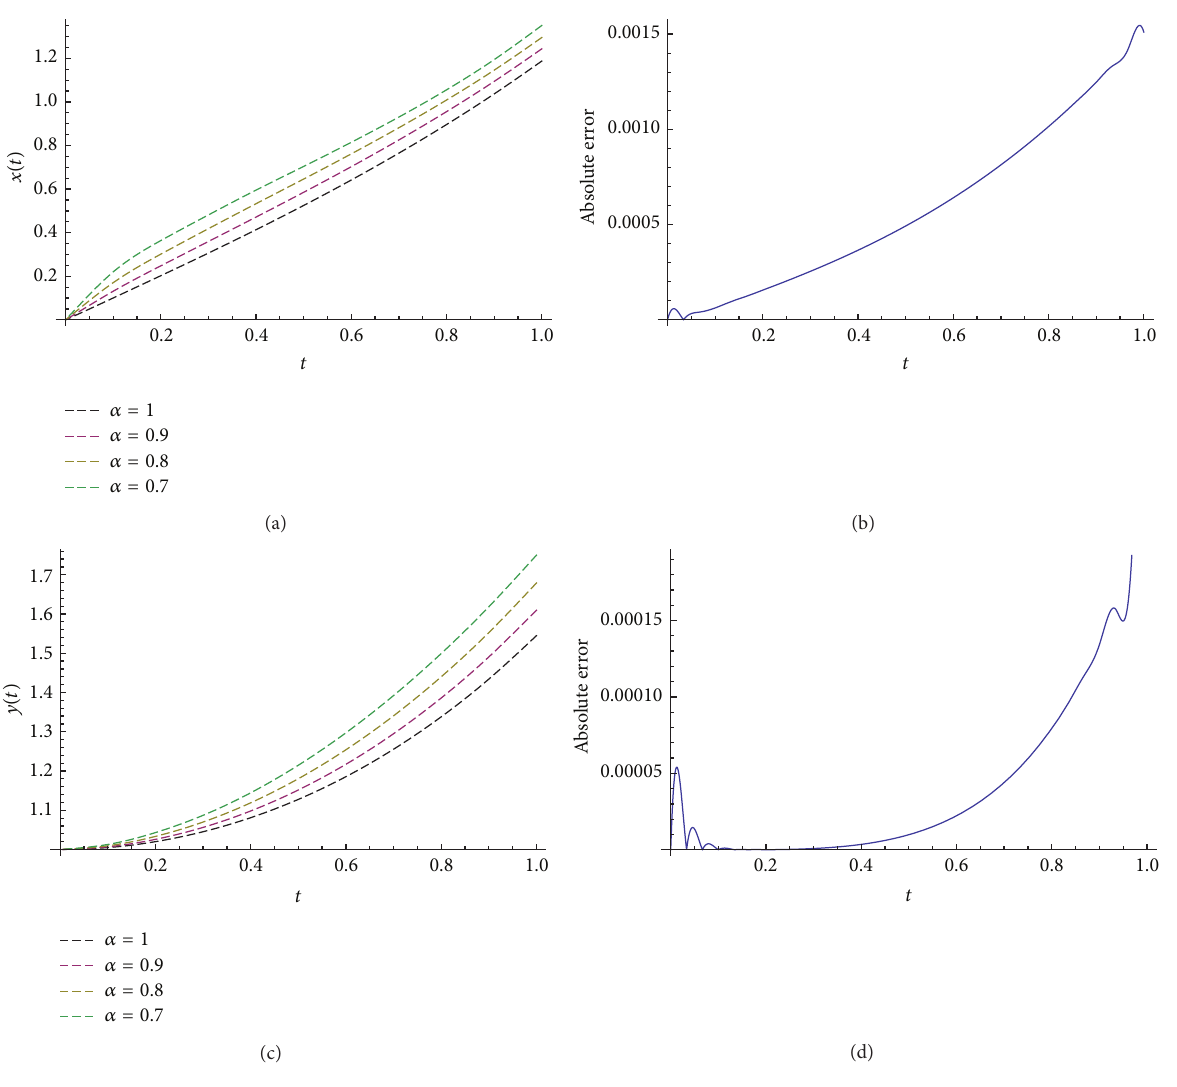
Figure 2: Graphical results for Example 2 when 𝛼 1 = 𝛼 2 = 𝛼 = 1,0.9, 0.8 , and